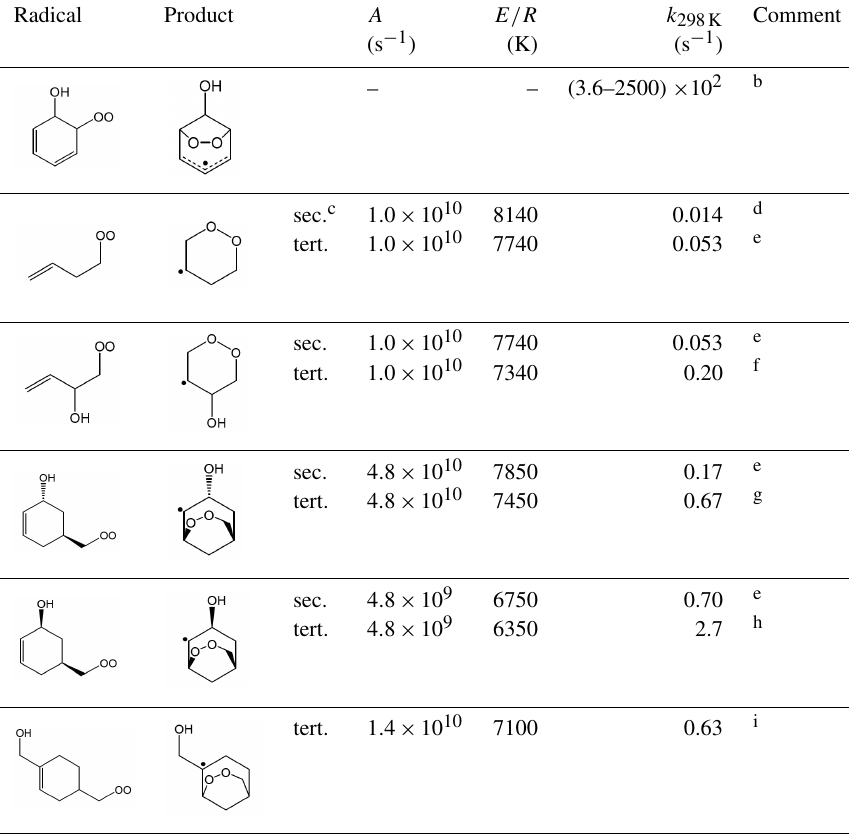
Table 14. Representative rate coefficients for template ring-closure reactions of peroxy radicals a